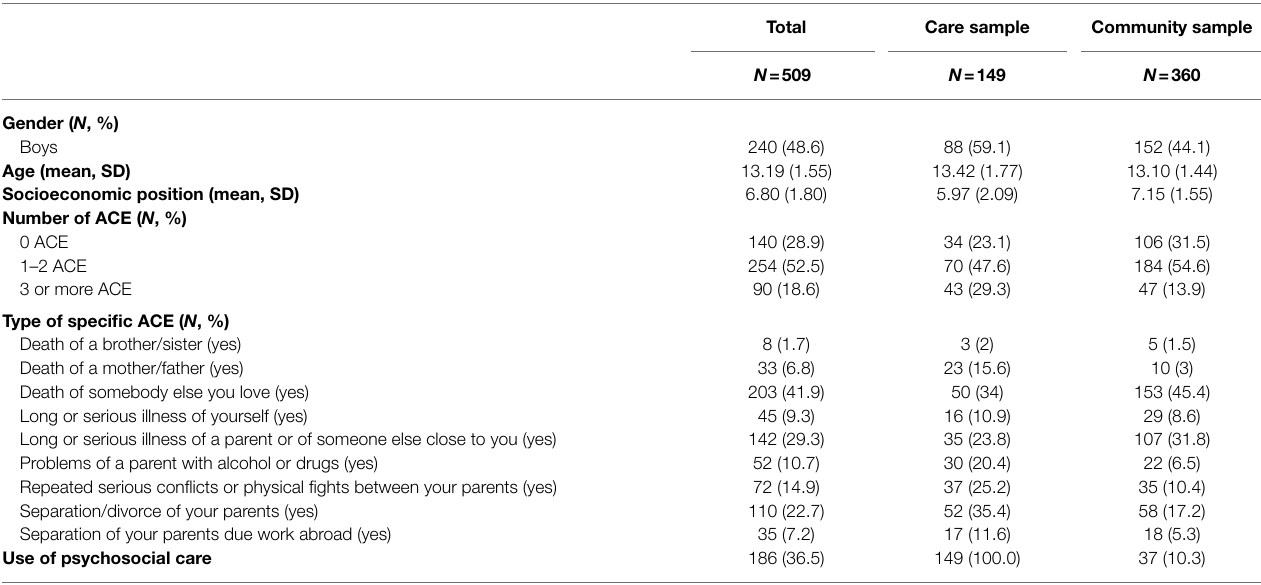
TABLE 1 | Descriptive statistics of the sample (Care4Youth study, Slovakia 2017, 10–16 years old, N =